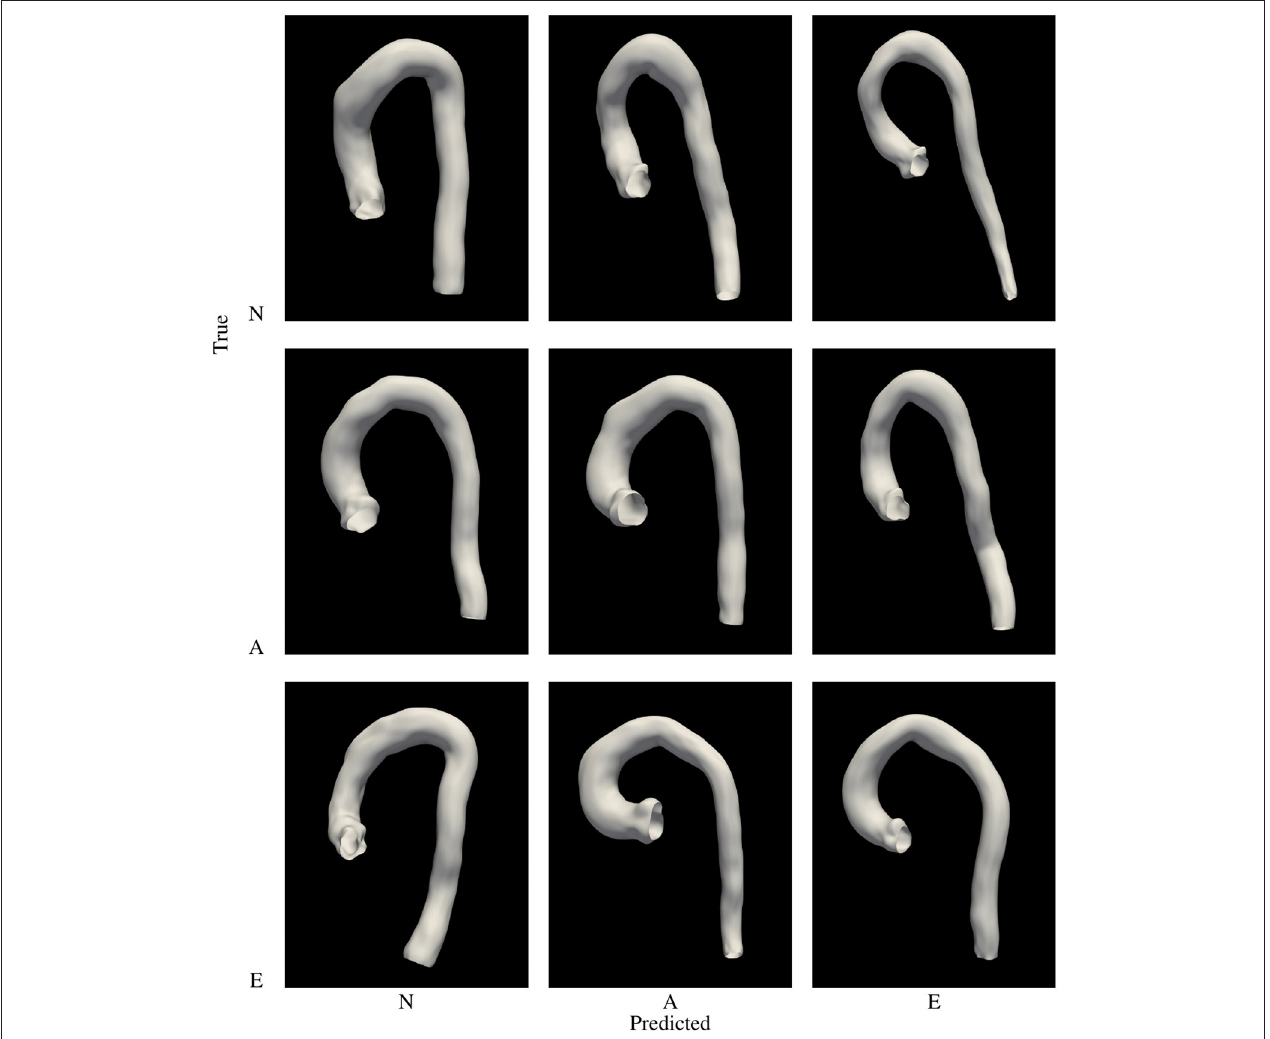
FIGURE 9 | Graphic representation of the confusion matrix of P p . Examples of aortas of phenotype N , A and E row-wise, with the phenotype predicted column-wise